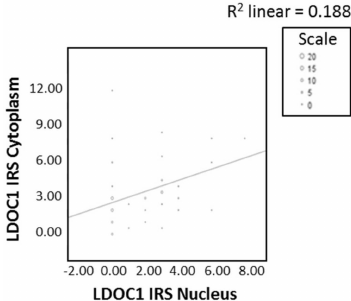
Figure 2. Correlation analysis of cytoplasmatic and nuclear expression of LDOC1. A significant correlation between cytoplasmatic and nuclear expression of LDOC1 was determined by Spearman correlation analysis ( ρ = 0.412, p =